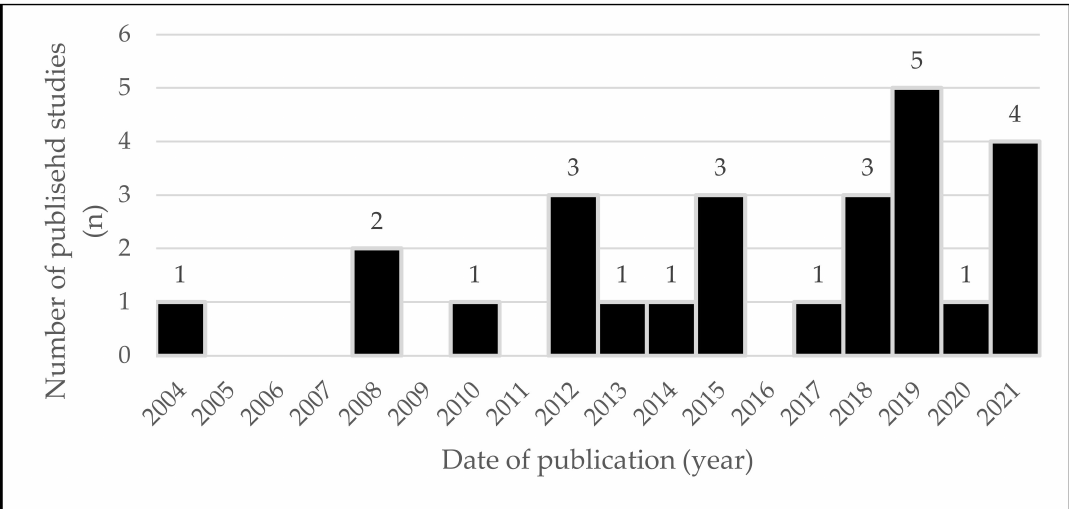
Figure 2. Number of published studies per year ( n